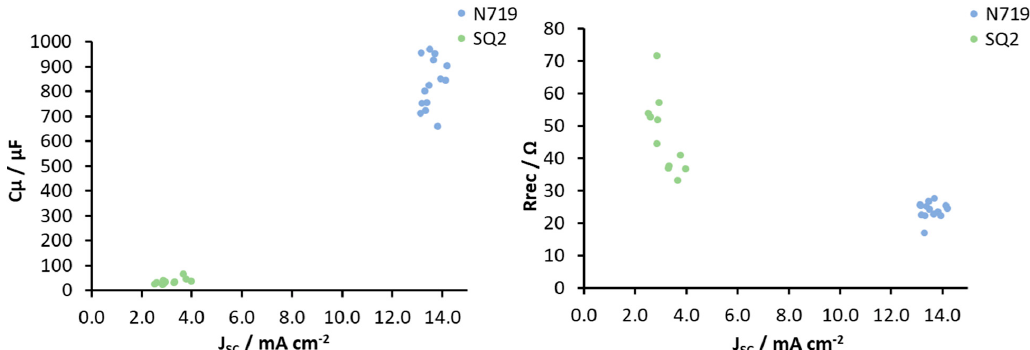
Figure 8. C μ and R rec presented as a function of J SC for the DSCs with the N719 and SQ2 dyes.